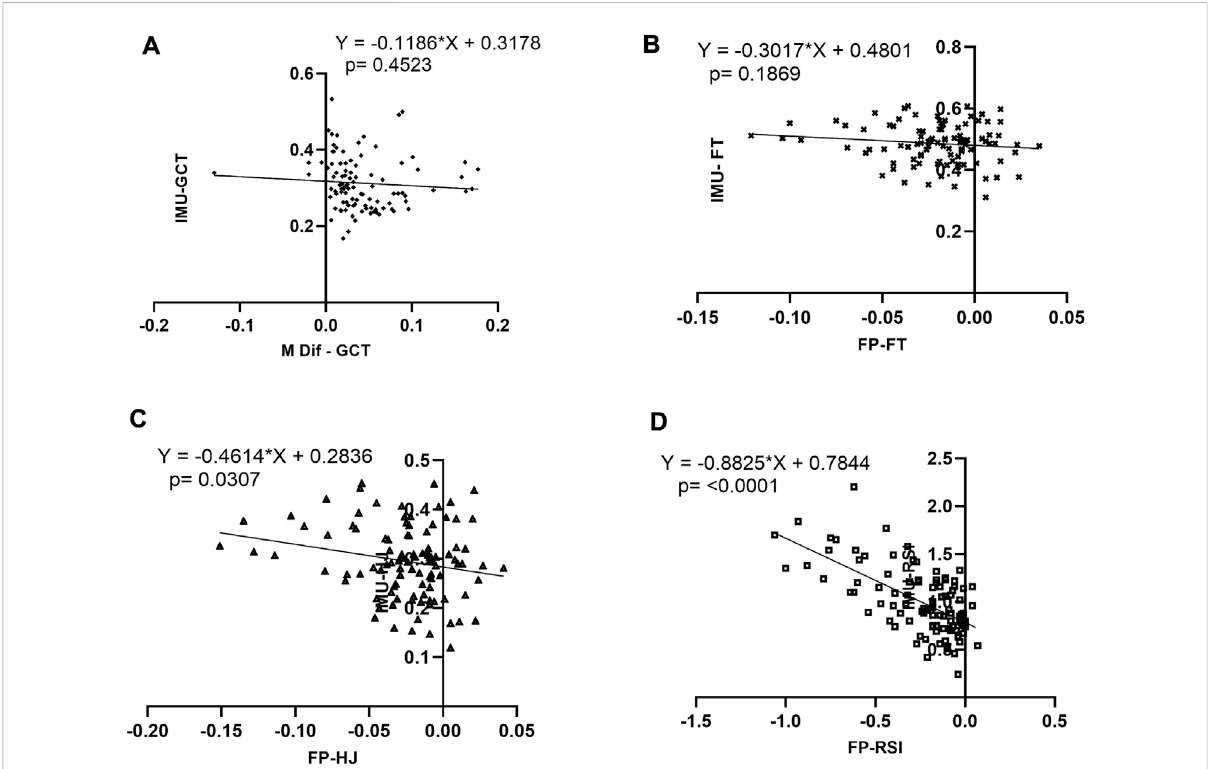
FIGURE 5 Simple linear regression (LR). The measurements are obtained from the difference of means vs. means for each. The (A) RL representation of GCT between IMU vs. FP; the (B) RL representation of FT between IMU vs. FP; the (C) RL representation of HJ between IMU vs. FP and the (D) RL representation of RSI between IMU vs. FP.